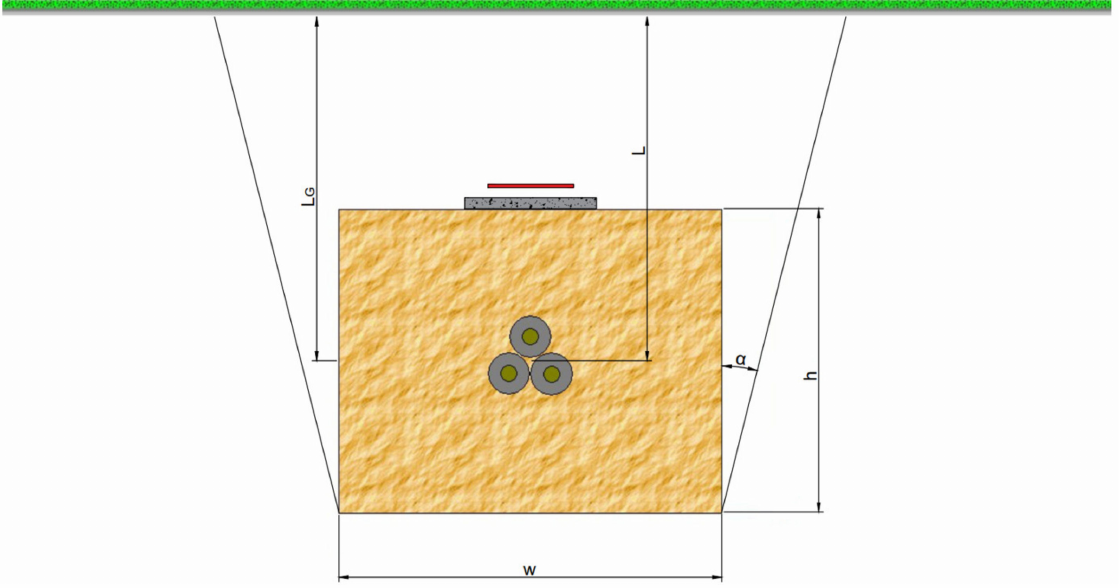
Figure 2. Cables in trefoil formation, placed in a backfill (for symbols see Figure